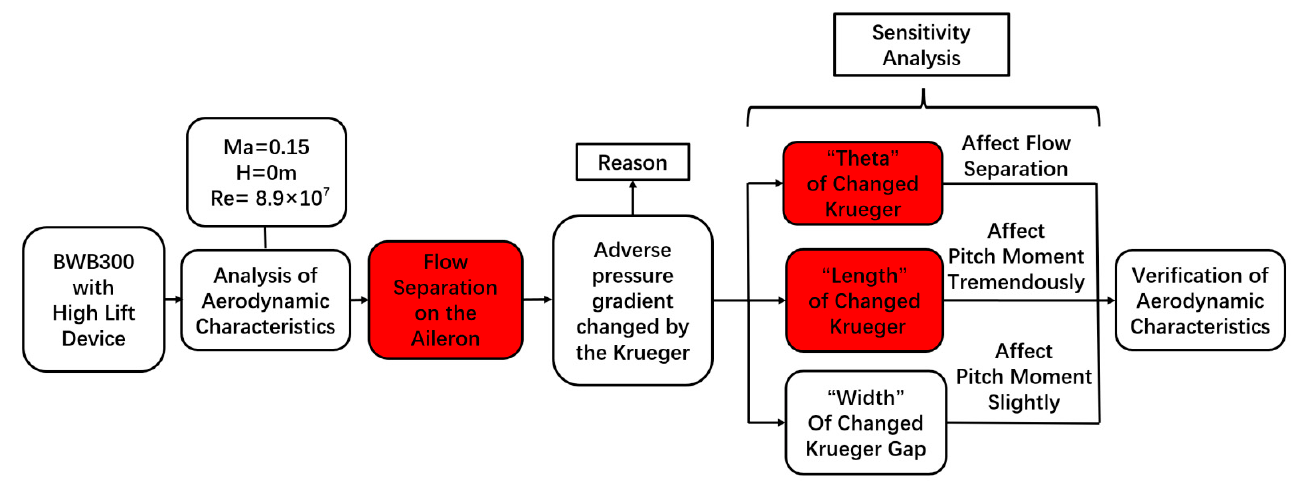
Figure 7. The surface flow of computation and experiment for the clean configuration.